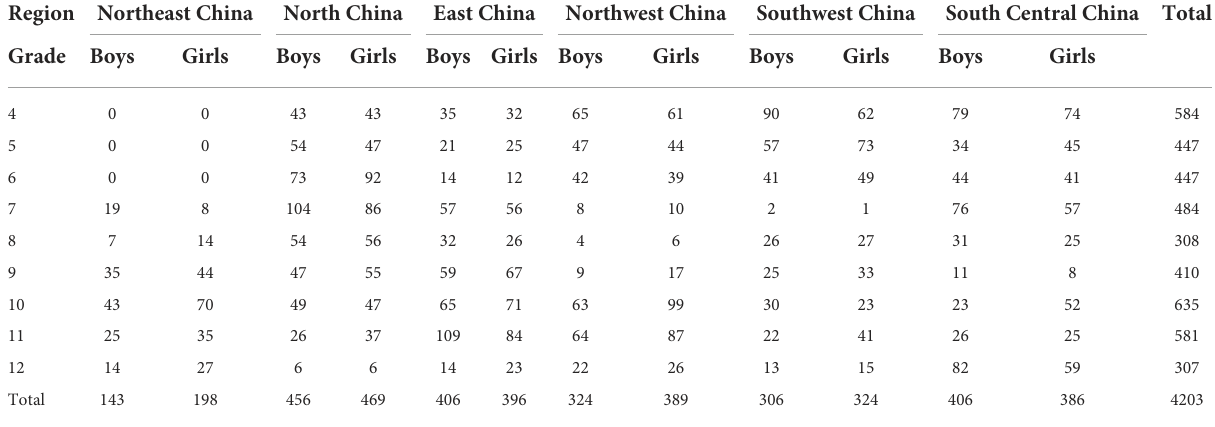
TABLE 1 Region, sex and grade distribution of children and adolescents. Region Northeast China North